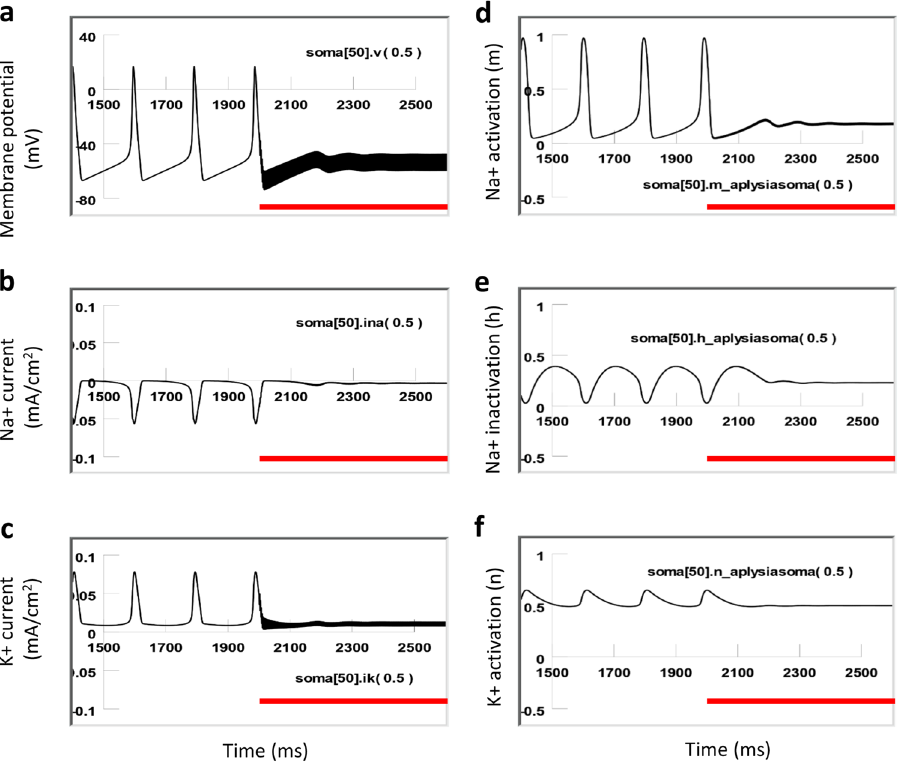
Figure 11. Ion channel dynamics of a relatively low-active neuron (5 Hz) under magnetic stimulation (red lines) with the miniature coil. ( a ) Membrane potential. ( b ) Na + current. ( c ) K + current. ( d ) Na + channel activation (m). ( e ) Na + channel inactivation (h). ( f ) K + channel activation